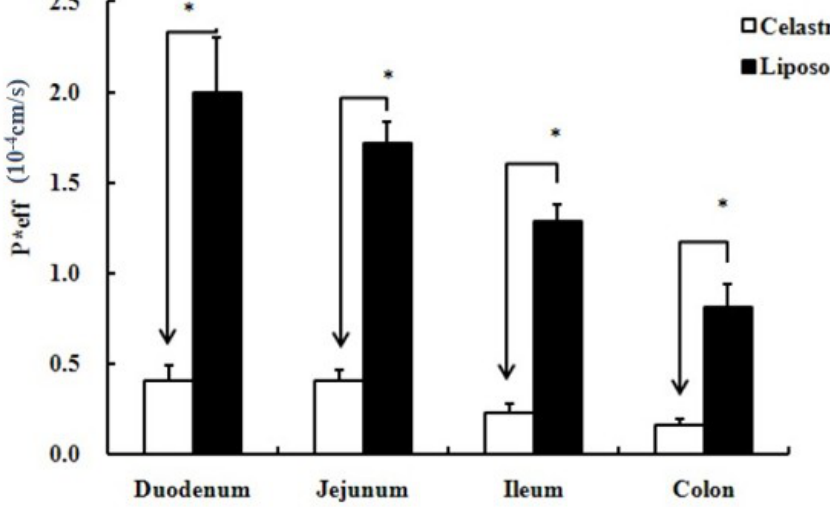
Figure 4. Comparison of P*eff (10 − 4 cm/s) (effective permeability) between four different intestinal segments. Data are expressed as mean ± SD (n = 5). The statistically significant difference is shown by the asterisk symbol, * P < 0.05.